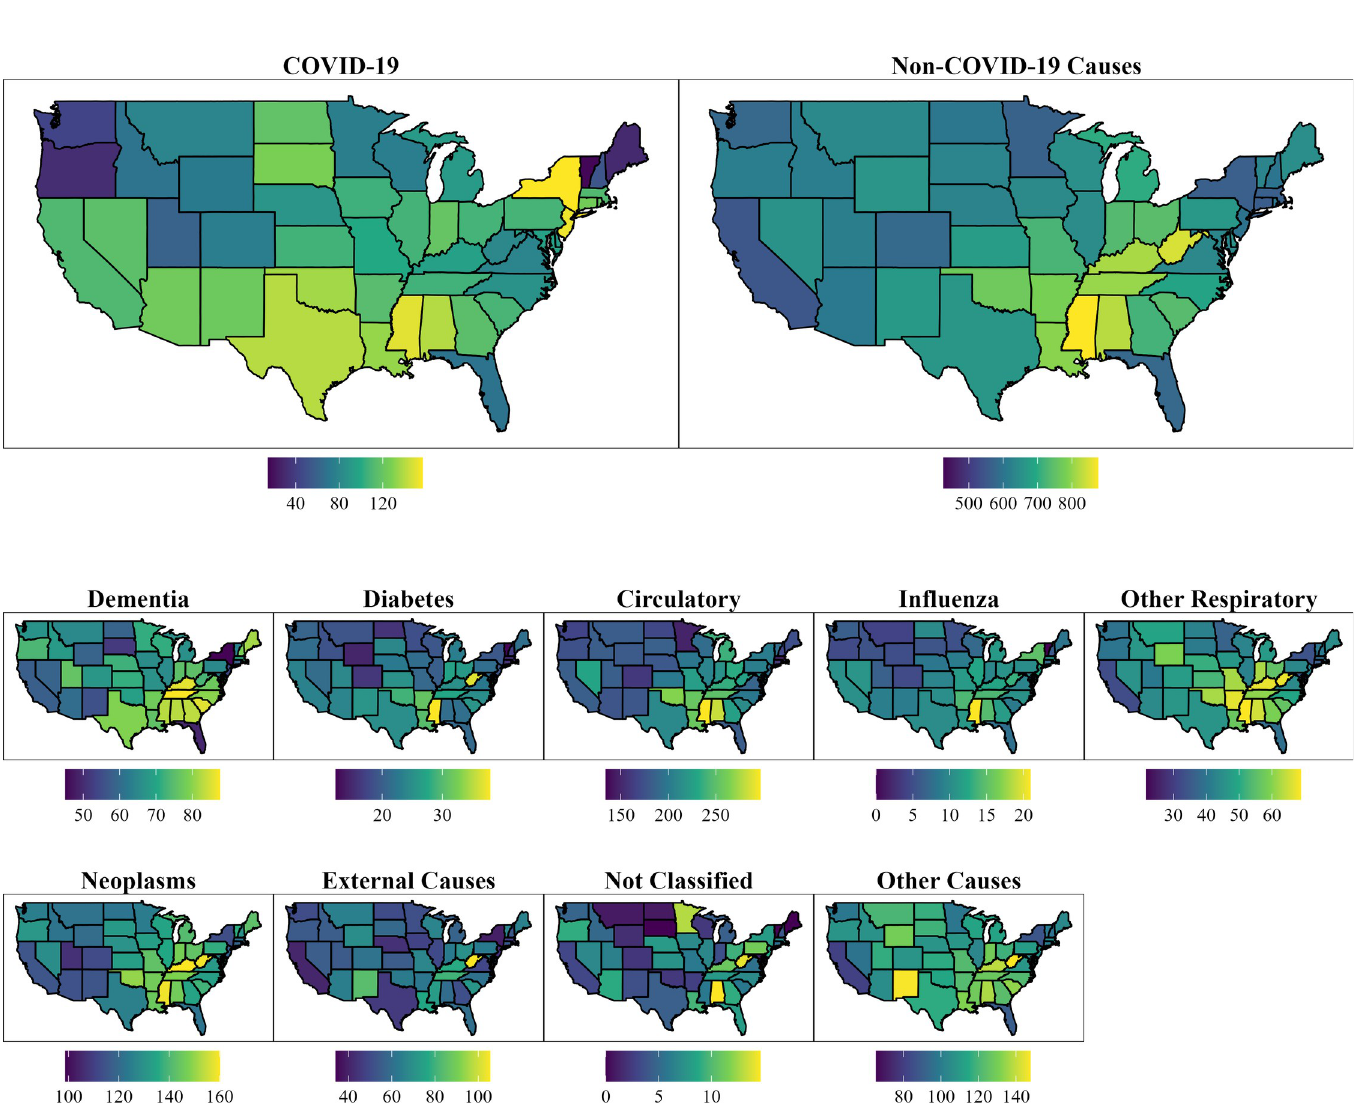
Fig 1. State distribution of cause-specific ASDR for ages 25+ from 3/2020-2/2021. Note: ASDR = age-standardized death rates. Units are deaths per 100,000.